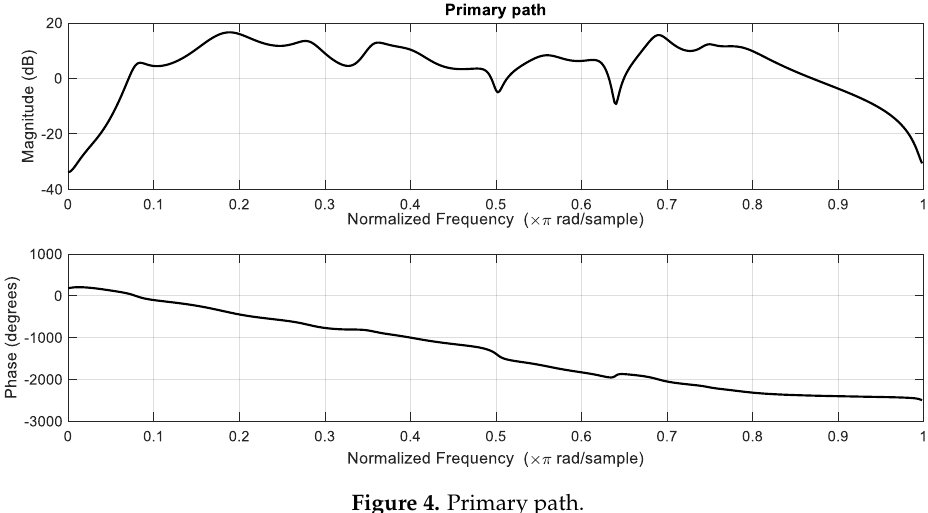
Figure 4. Primary path.